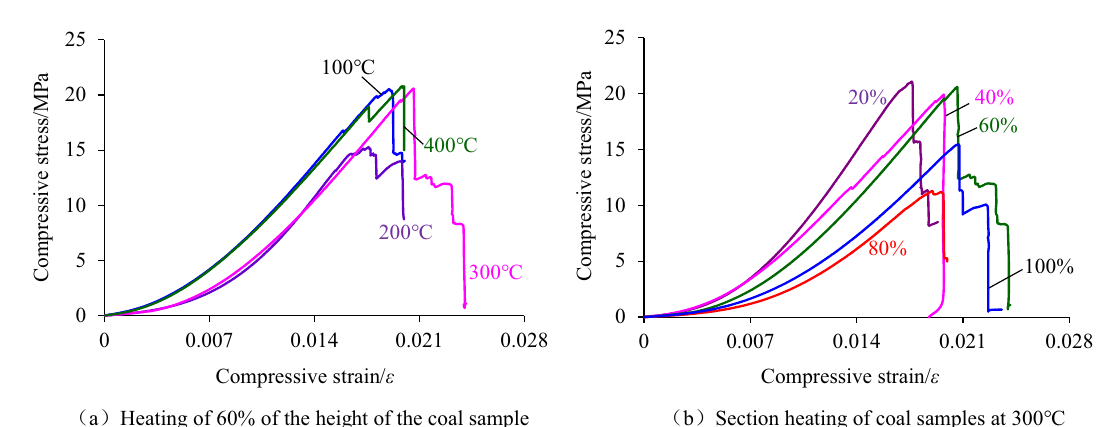
Figure 3. Compression stress–strain curve of coal sample after segmented high-temperature